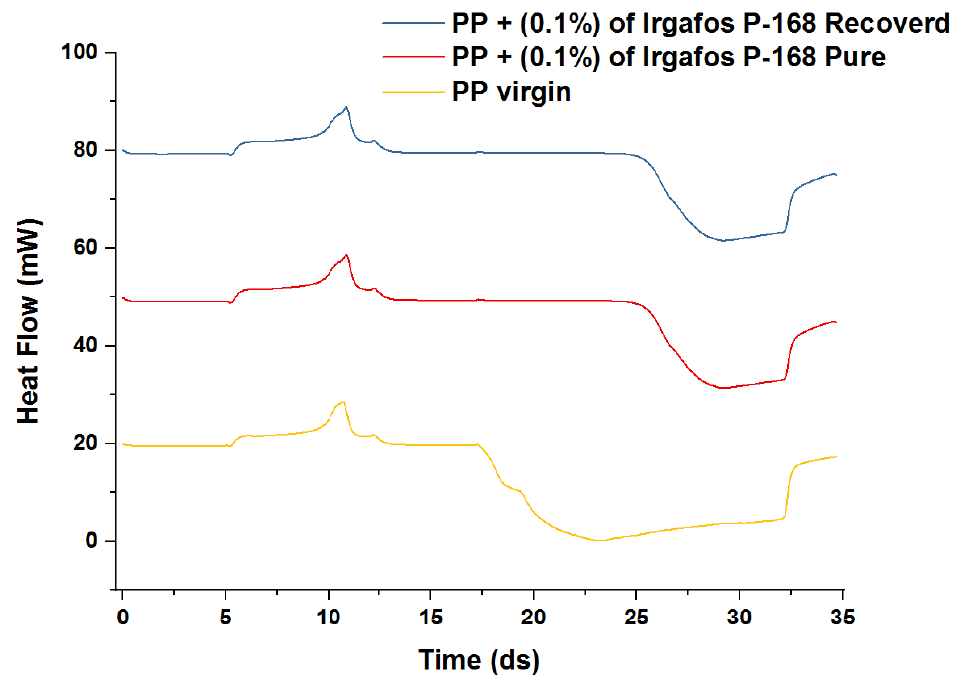
Figure 16. OIT PP, PP+ P-168 pure and PP + P-168 recovered.